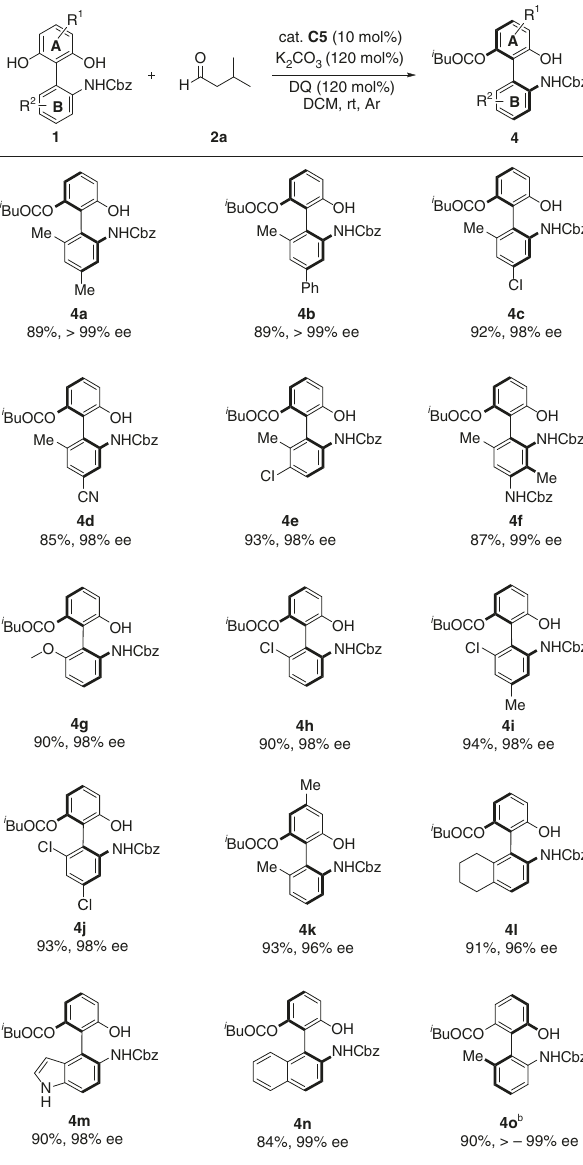
Fig. 3 Scope of biaryl biphenols. Reaction conditions: a mixture of 4a – 4o (0.10 mmol), 2a (0.15 mmol), K 2 CO 3 (0.12 mmol), and DQ (0.12 mmol) in CH 2 Cl 2 (1.0 mL) was stirred at room temperature under N 2 for 12 – 24 h. b ent-cat. C5 was used